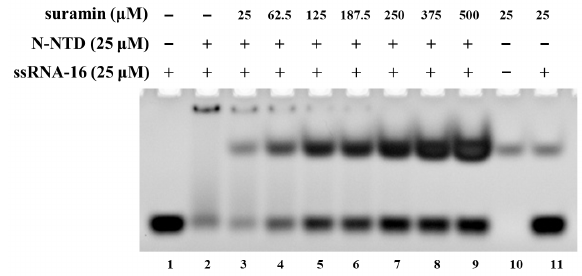
Figure 2. EMSA experiment for suramin disturbing the association between SARS-CoV-2 N-NTD and ssRNA-16. Lane 1: free ssRNA-16; lane 2: mixture of N-NTD with ssRNA-16 at the molar ratio of